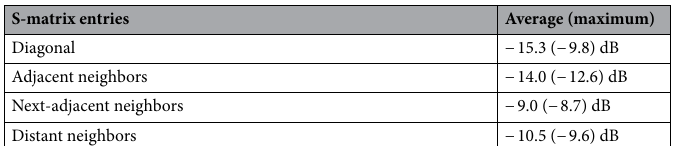
Table 2. Summary of the 6 × 6 scattering matrix of the cable coil in Fig. 8. The average (maximum) values are listed for each collection of entries in the